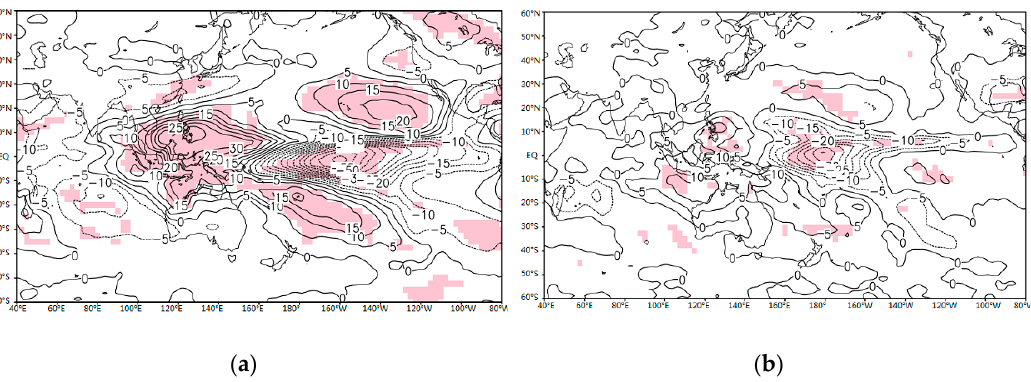
Figure 8. Composite OLR (units: W·m − 2 ) anomalies during DJF 1979–2016 for the ( a ) spring and ( b ) summer El Niño events. The contour interval is 5 W·m − 2 . Shaded areas are statistically significant at the 95% confidence level, based on the Student’s t -test.